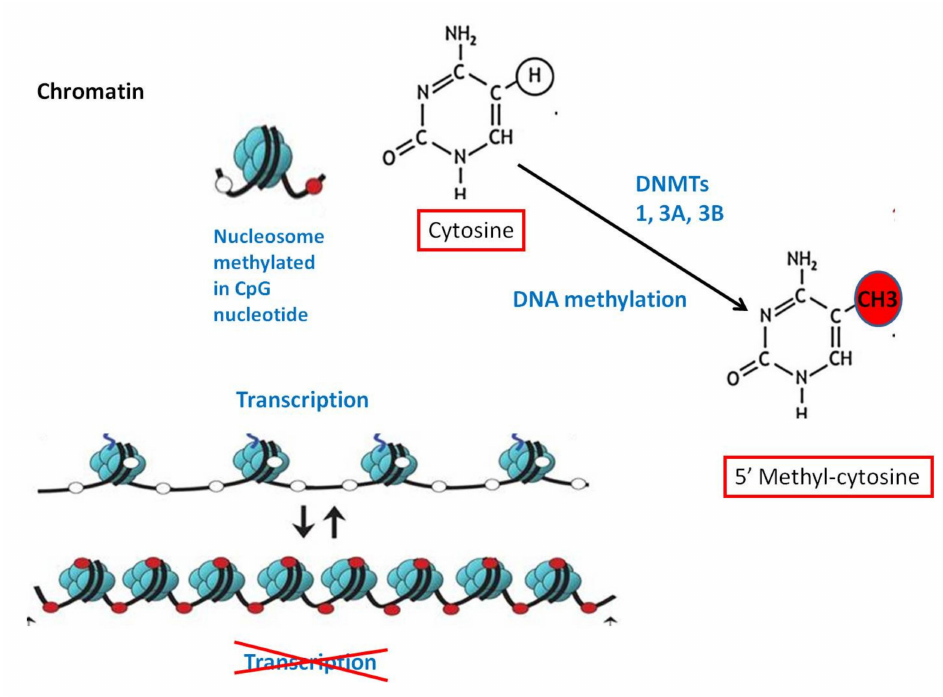
Figure 2. DNA methylation (of the cytosine pyrimidine ring catalyzed by the enzyme methyltransferase) is an “epigenetic switch” that regulates the balance between “open” and “closed” form of chromatin and ultimately resulting in gene